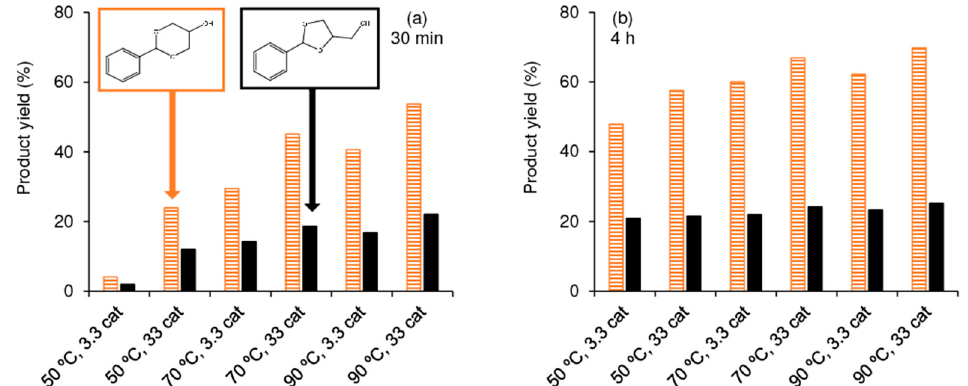
Figure 3. The dioxane (striped bars) and dioxolane (black bars) yields at 30 min ( a ) and 4 h ( b ) for the Bza/Gly reaction at 50, 70 and 90 °C using different catalyst mass loads (3.3 or 33 g cat L − 1 ).